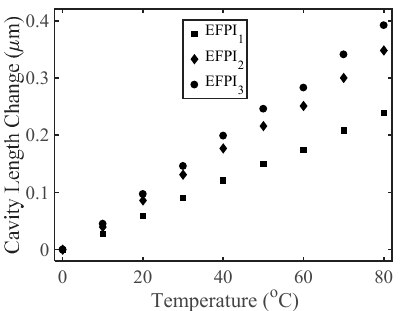
Figure 5. Measured cavity length change of EFPI 1 , EFPI 2 , and EFPI 3 with respect to temperature.